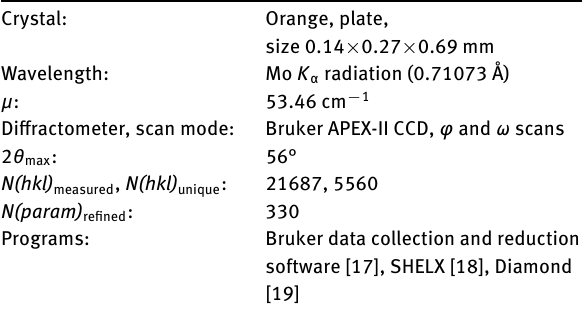
Table 1: Data collection and